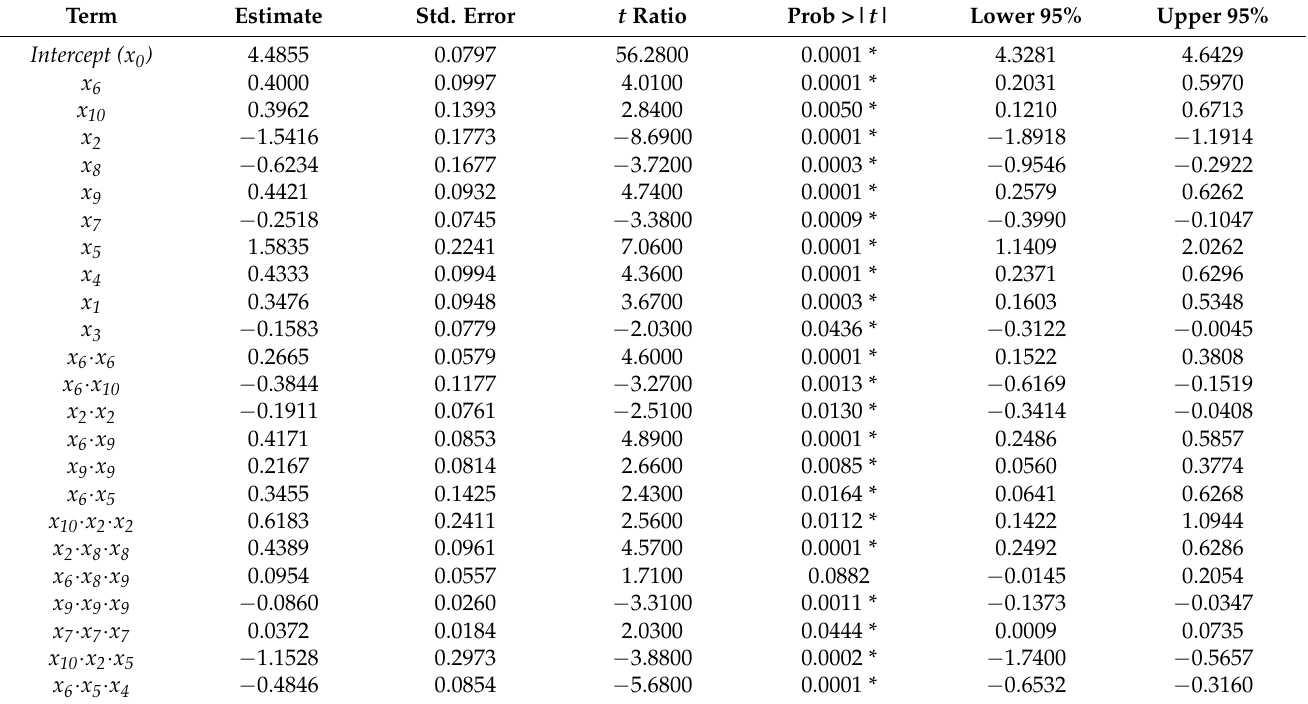
Table 6. The regression coefficients of the developed nonlinear model of the Basel AML